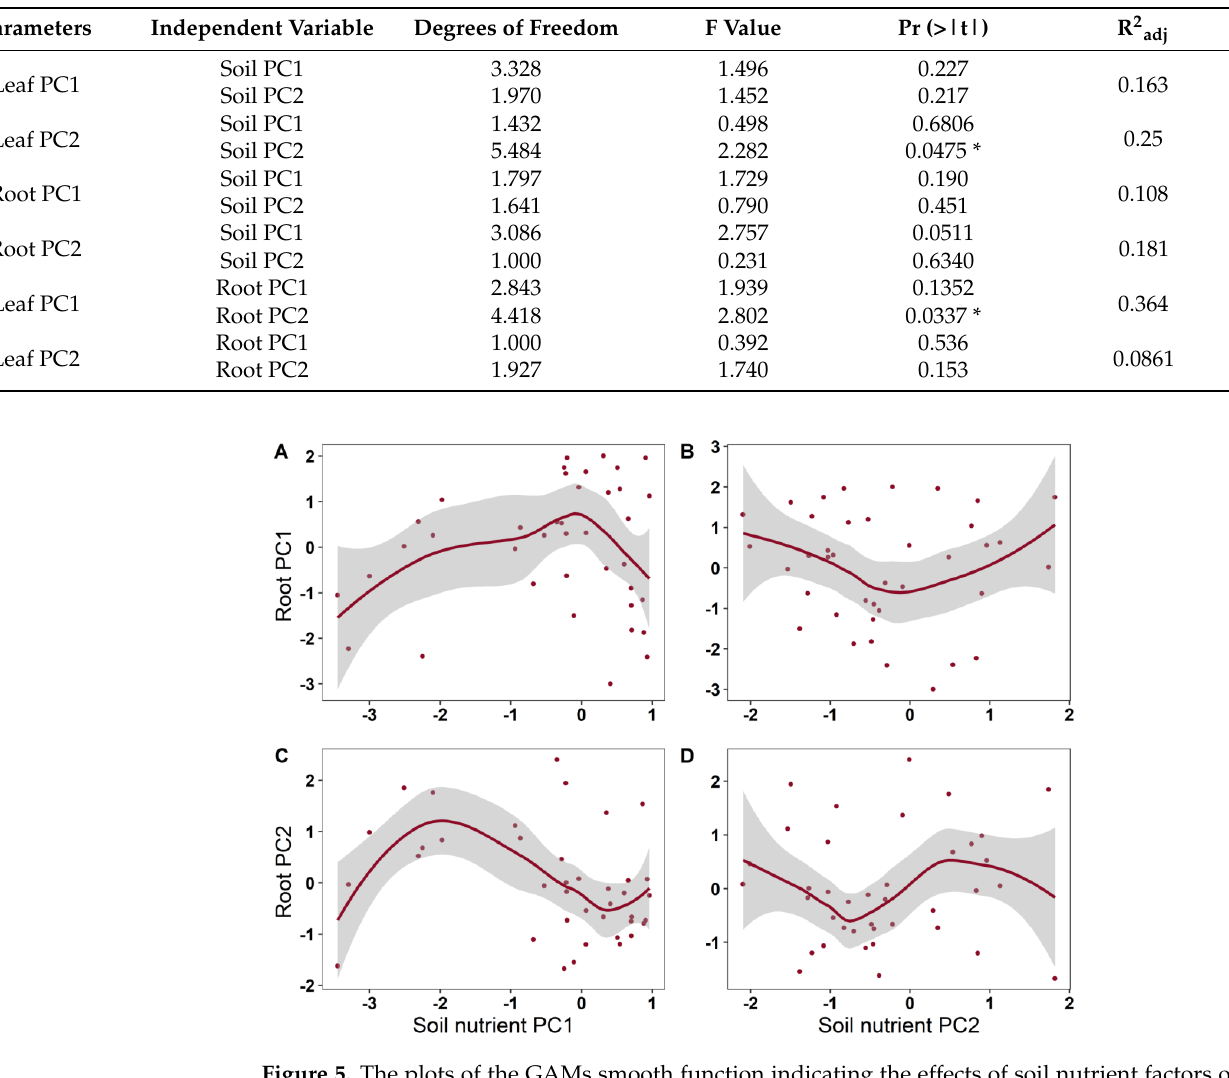
Figure 5. The plots of the GAMs smooth function indicating the effects of soil nutrient factors on root nutrient traits. ( A ): soil nutrient PC1 vs. root PC1; ( B ): soil nutrient PC2 vs. root PC1; ( C ): soil nutrient PC1 vs. root PC2; ( D ): soil nutrient PC2 vs. root